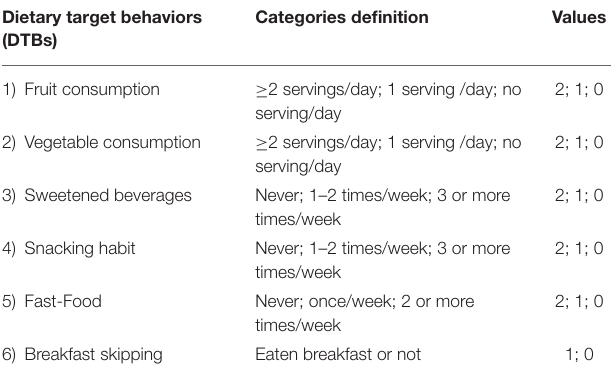
TABLE 2 | Dietary target behaviors. Dietary target behaviors (DTBs)